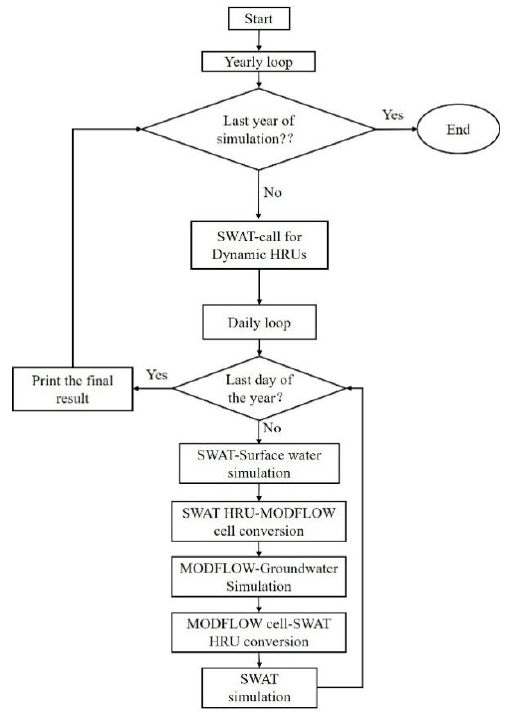
Figure 4. Flowchart of the SWAT ‐ MODFLOW coupled model based on dynamic HRUs.